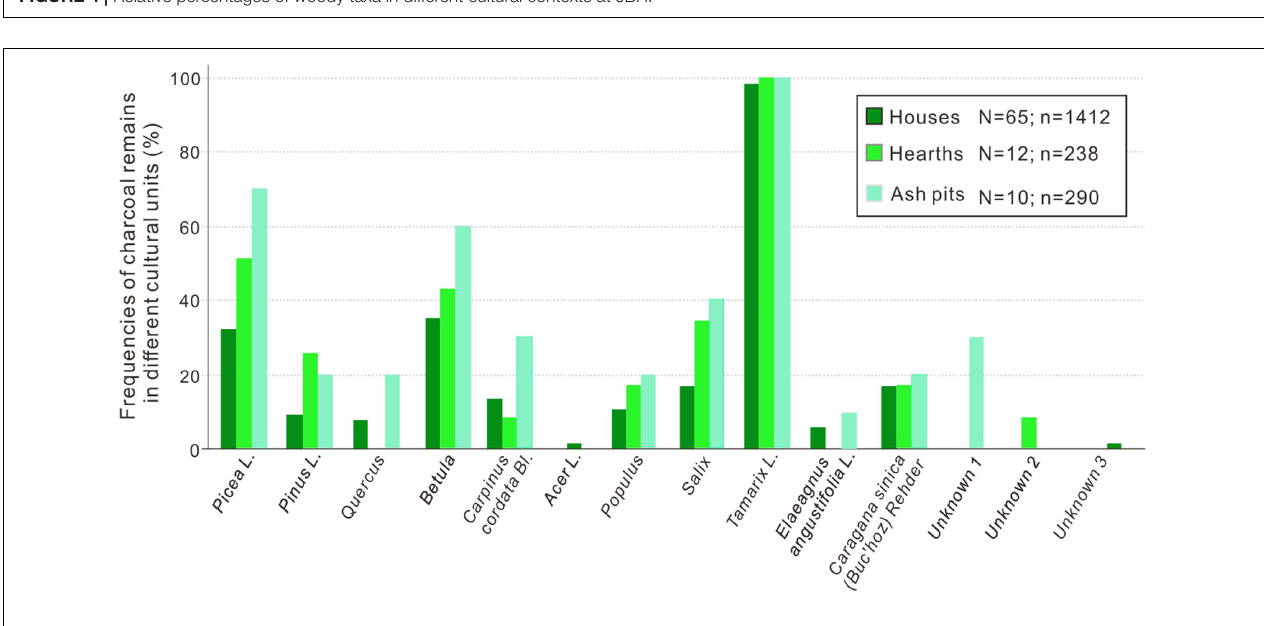
FIGURE 4 | Relative percentages of woody taxa in different cultural contexts at JBR.